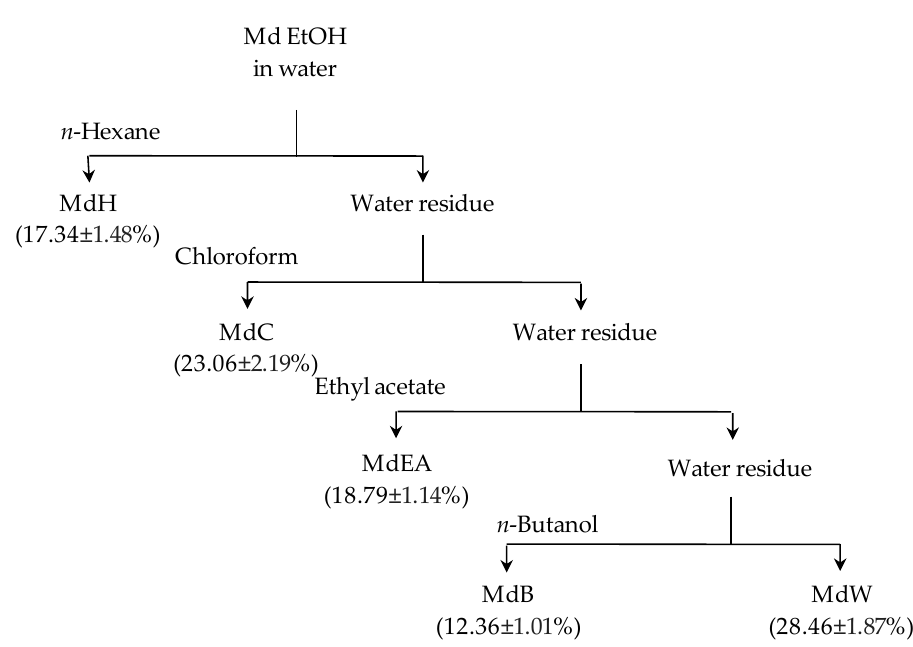
Figure 1. Extraction yields (%) of M. diffusa EtOH extract partitioned fractions with solvents of different polarities. Results are expressed as mean ± standard deviation of the triplicate experiments. Samples are crude ethanol extract (Md EtOH), n -hexane fraction (MdH), chloroform fraction (MdC), ethyl acetate fraction (MdEA), n -butanol fraction (MdB) and water fraction (MdW).